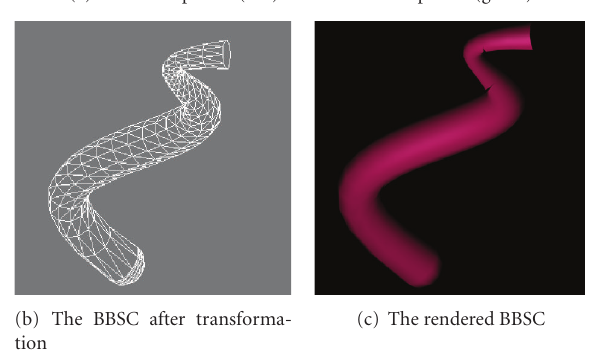
Figure 1: A BBSC created by